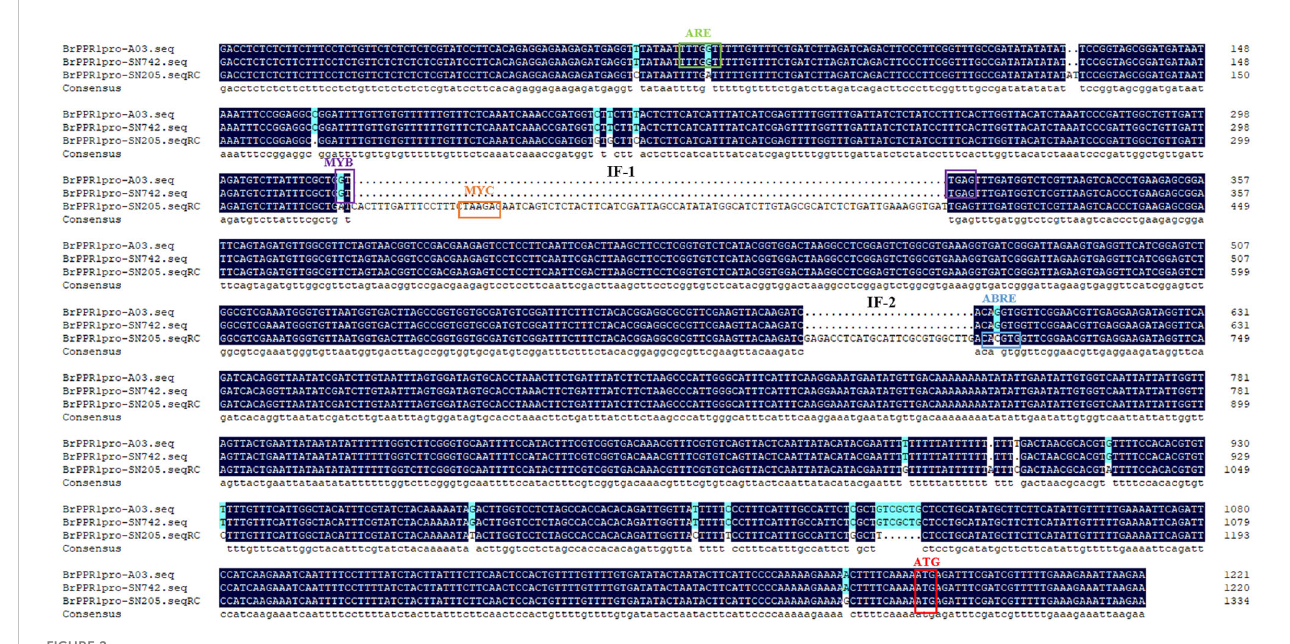
FIGURE 2 Promoter sequence and element analysis of BrRPP1 in resistance and susceptible materials of Chinese cabbage.